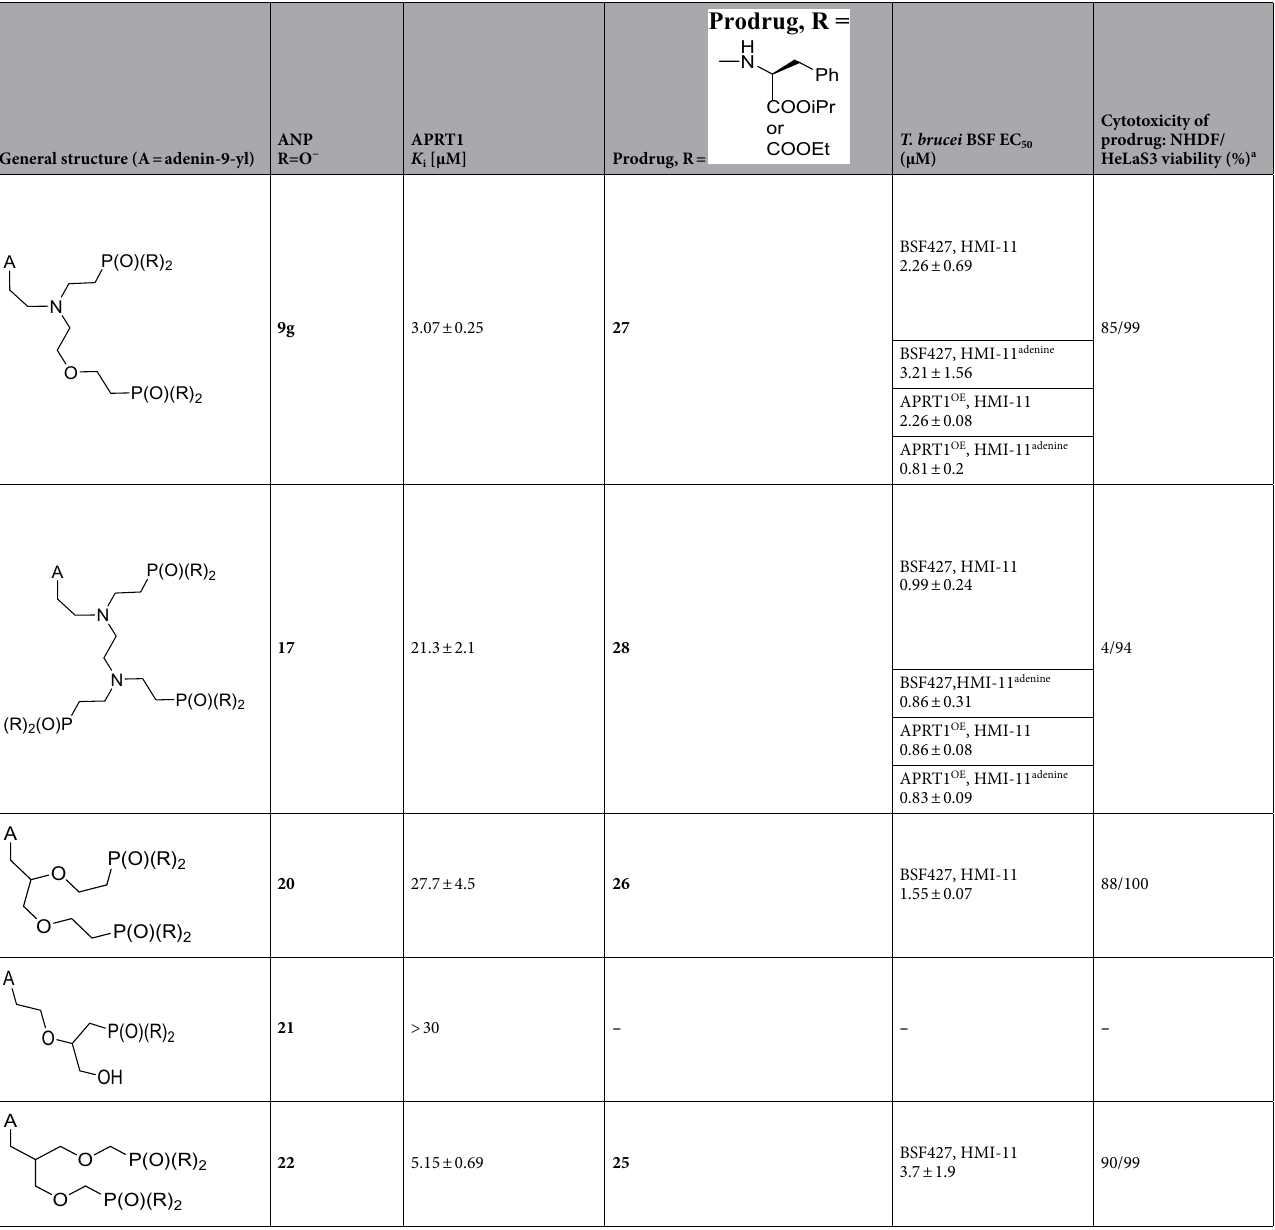
Table 1. Ki values of the synthesized ANPs for APRT1 and anti-trypanosomal activity of their